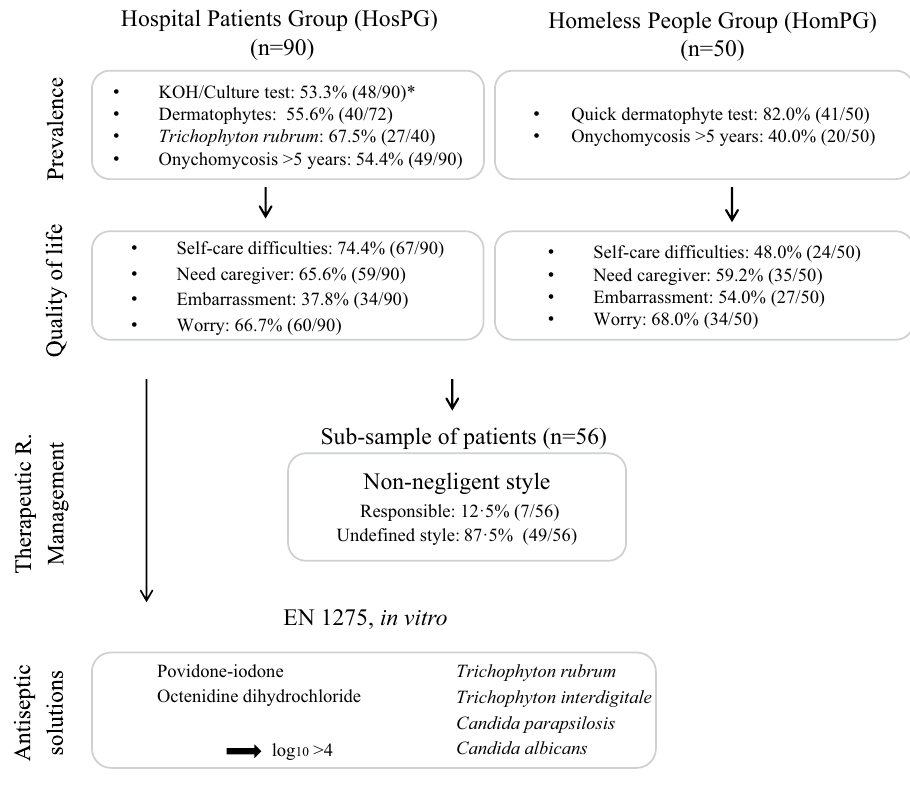
Figure 2. Comparison of results from the Hospital Patients Group (HosPG) and Homeless People Group